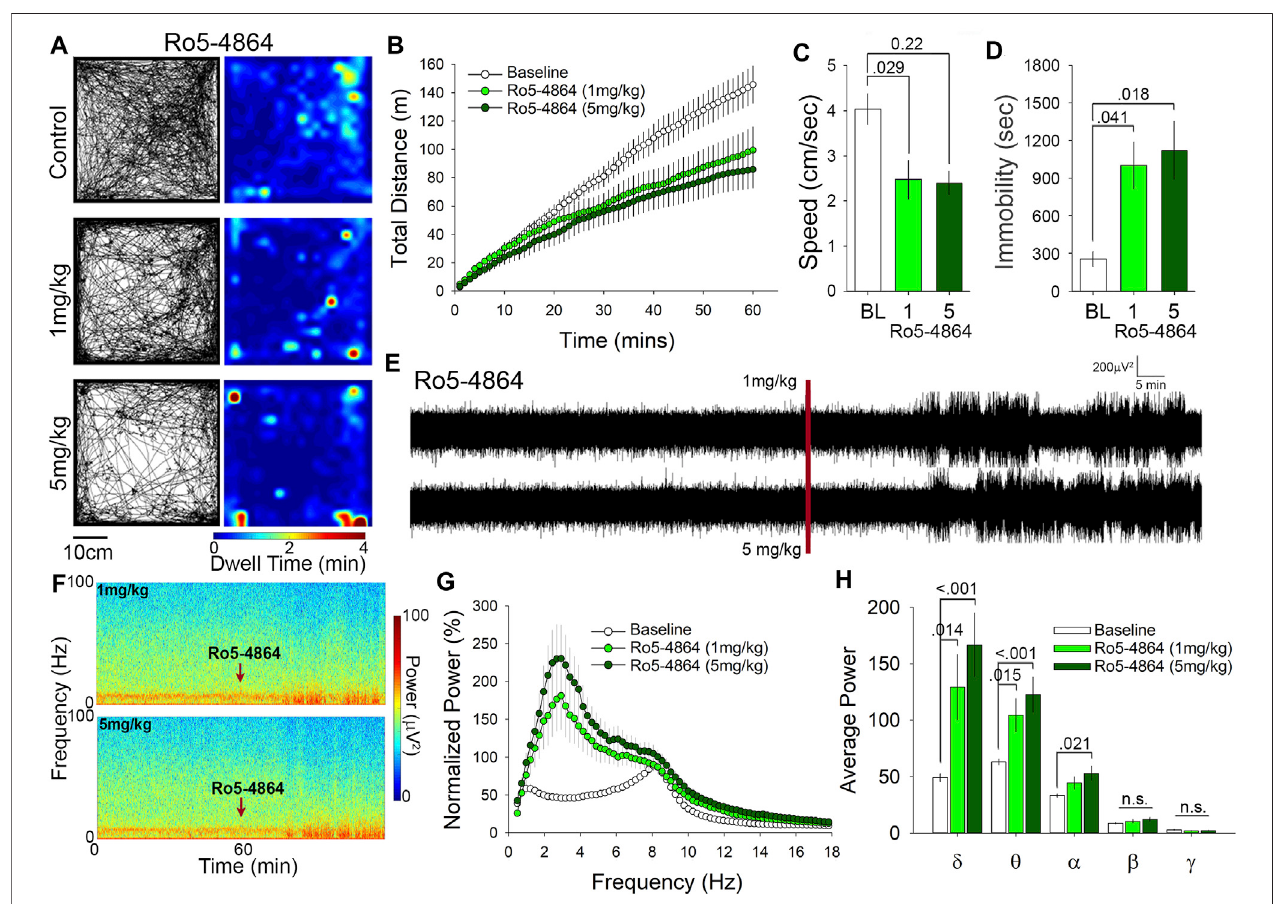
FIGURE3| Ro5-4864reduceslocomotionintheopen fi eldandincreases δ and θ poweratboth1and5 mg/kg. (A) Representativepathsandheatmapsofanimal positionthroughout the open fi eld. (B) Cumulative distance traveled and average speed. (C) were signi fi cantly reduced inanimalstreated with both 1 and 5 mg/kg Ro5- 4864. (D) Treatment with Ro5-4864 also increased time immobile. (E) Raw traces and spectrograms (F) of 2-h recording period, with the red line and arrows indicating timeofi. p.injection. (G) cFFT comparing 1-h baseline recordings torecordingsfollowing i. p.injection of1 mg/kg and 5 mg/kg Ro5-4864. (H) Spectralanalysisof speci fi c frequency bands in the EEG reveals increases in δ and θ power with both 1 and 5 mg/kg Ro5-4864, along with an increase in α power at the higher dose of 5 mg/kg.